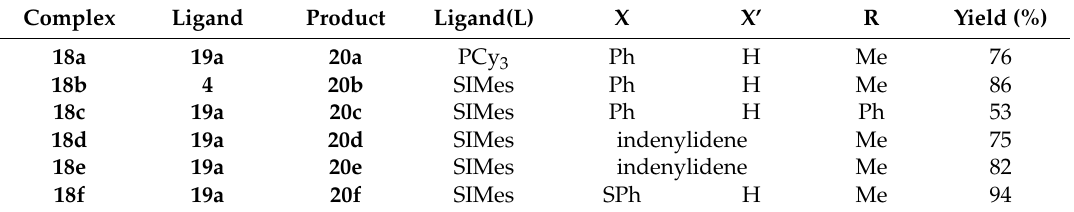
Table 1. Yields in the synthesis of pyridine alkoxide substituted precatalysts 20a – f [35].